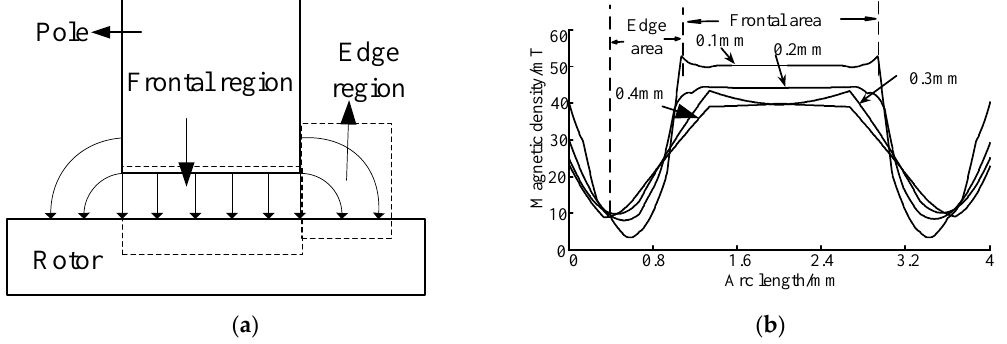
Figure 3. ( a ) Schematic diagram of the edge effect. ( b ) Relationship between the edge effect flux density distribution and the length of the air gap.